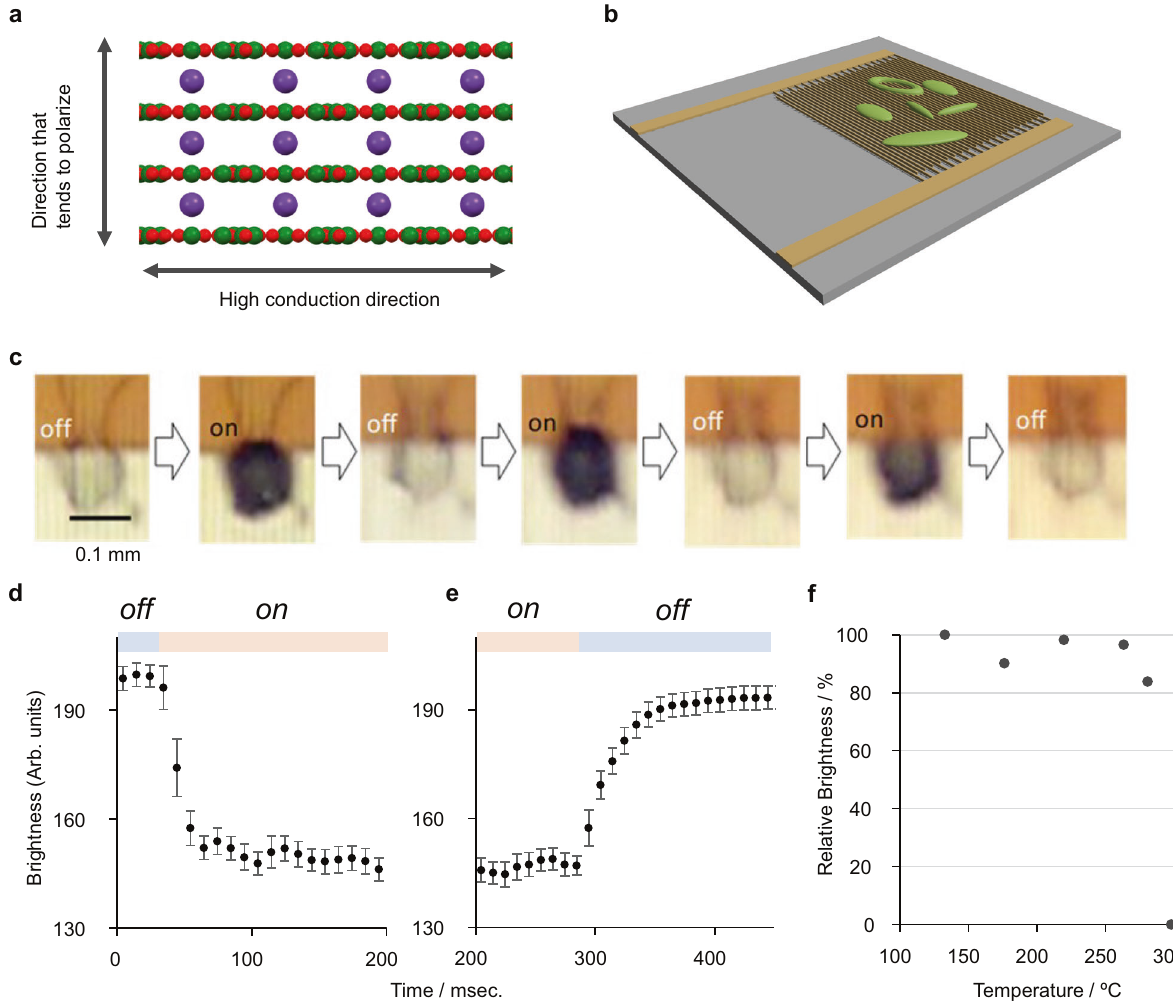
Fig. 4 BoL-LC inorganic optical device. a Schematic of the conceivable dynamic scattering phenomenon by BoL-LC. Spheres in the structure represent the constituent elements (green: boron, red: oxygen, purple: potassium). b Diagram of a BoL-LC device fabricated using a comb electrode. c On/off optical switching induced by an applied voltage (1 V). Response speed of the device; d , e correspond to the changes of the on and off states, respectively. The error bars in d , e stand for the standard deviation of ten observed values. f Temperature dependency of the repetition feature in the BoL-LC